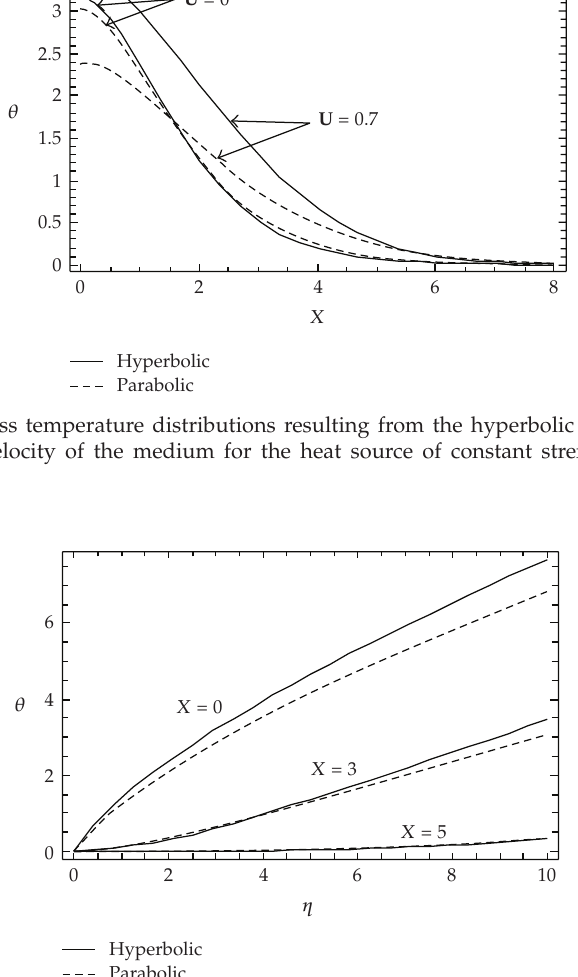
Figure 2: Variation of dimensionless temperature with dimensionless time at di ff erent points of the body for the heat source of constant strength; φ (cid:3) η (cid:4) (cid:5) 1 , ψ 0 (cid:5) 1 , and U (cid:5) 0 . 1